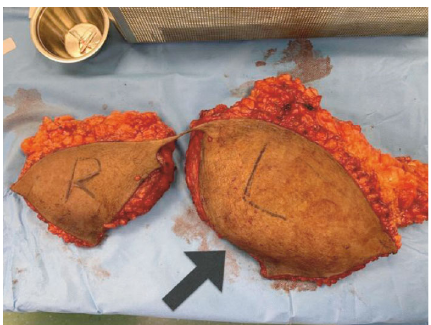
Figure 4: Excised specimen. Weight,